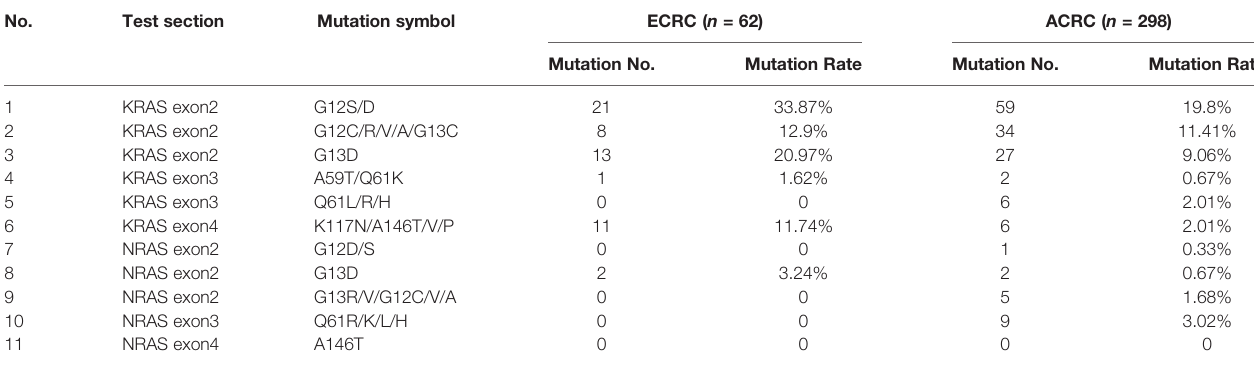
TABLE 4 | Mutant sites in early and advanced cancer.